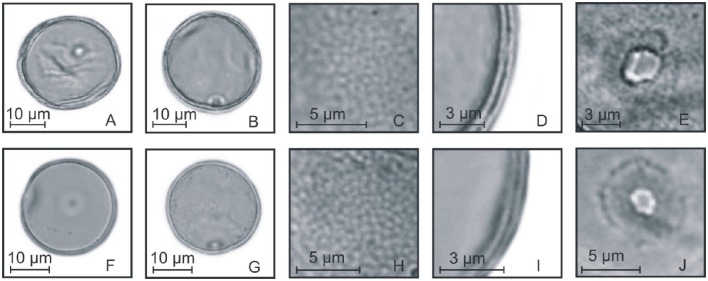
Pollen grains of the subfamily Panicoideae. (A–E)
Schizachyrium microstachyum: PV (A), EV (B), detail of ornamentation (C), detail of the thickness of the exine (D), and detail of the aperture (E); (F–J)
Arundinella hispida: PV (F), EV (G), detail of ornamentation (H), detail of the thickness of the exine (I), and detail of the aperture (J).